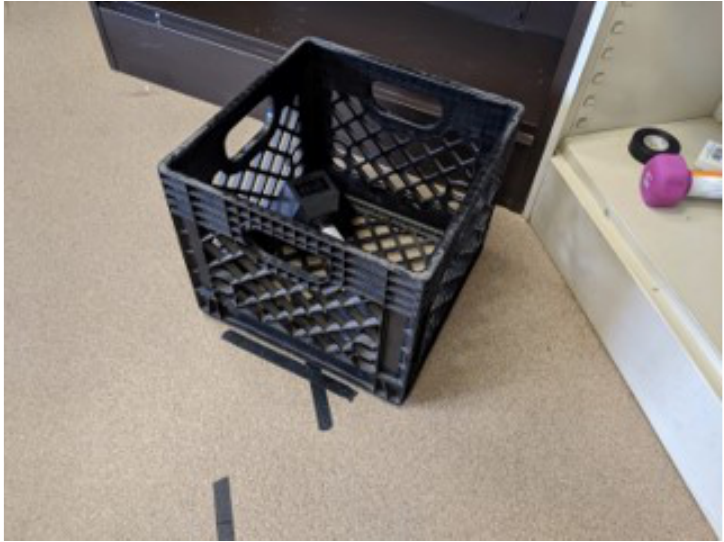
Figure 3. Crate aligned with a tape mark at the beginning of a twisting